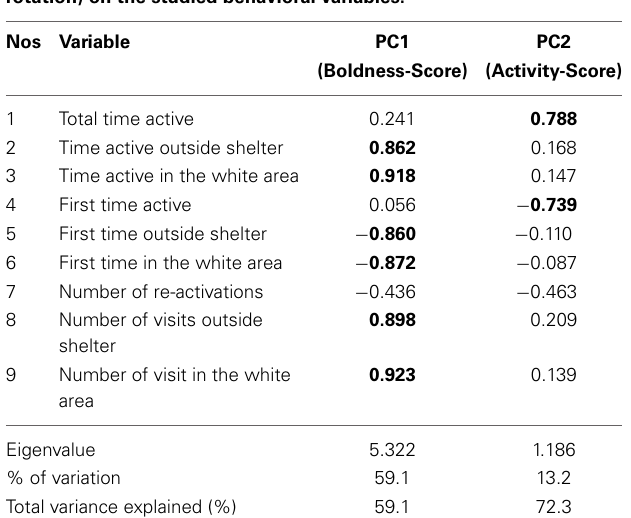
Table 1 | Results of the principal component analysis (with Varimax rotation) on the studied behavioral variables.